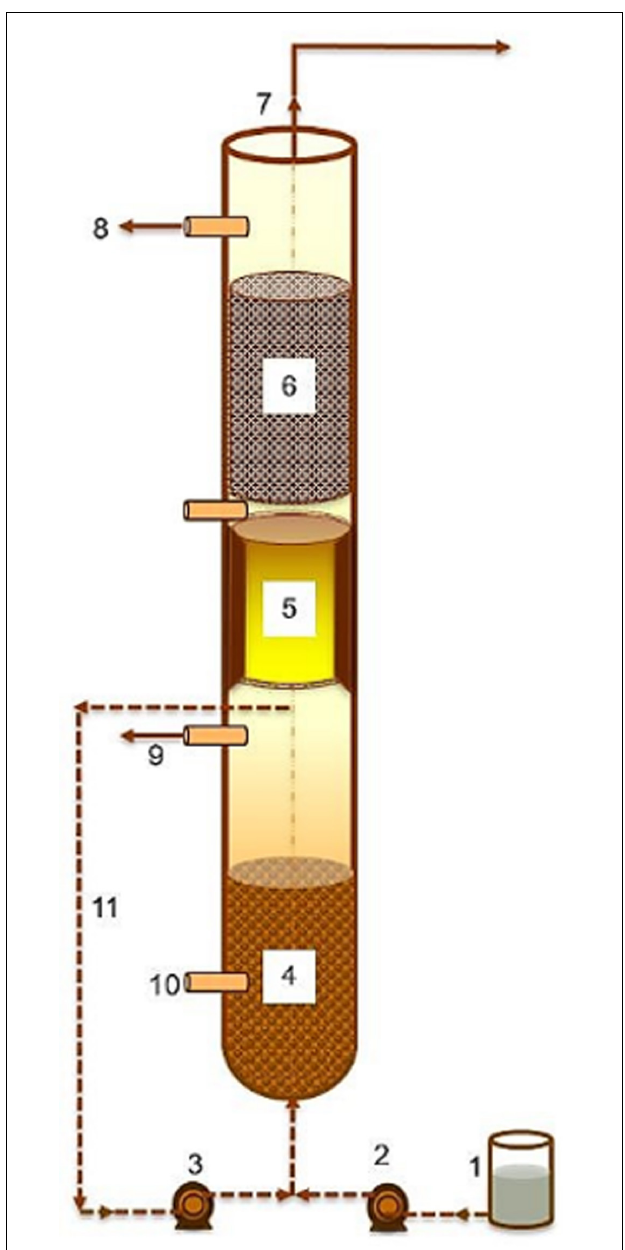
FIGURE 1 | Schematic representation of the components of the dynamic sludge chamber fixed film (DSC-FF) reactor design. (1) Influent tank, (2) peristaltic pump (feed), (3) Peristaltic pump (recirculation), (4) granular sludge bed, (5) anaerobic flotation zone, (6) anaerobic fixed-film (FF) compartment, (7) biogas collection, (8) effluent outlet and sampling, (9) sampling port (for post-granular chamber samples), (10) sampling port (for granular sludge), and (11) liquid